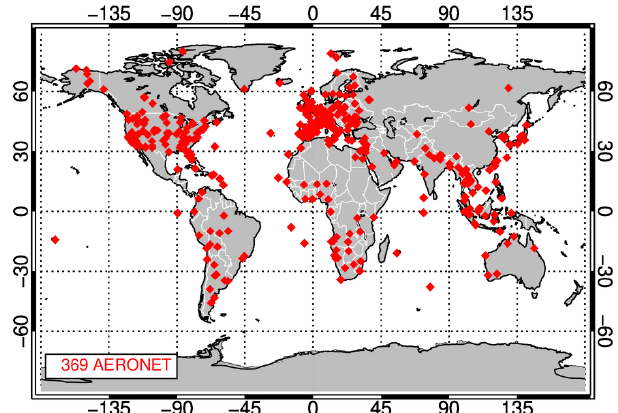
Figure 2. Spatial distribution of the 369 AERONET ground-based stations used for the comparisons to the TROPOMI/S5P TCWV